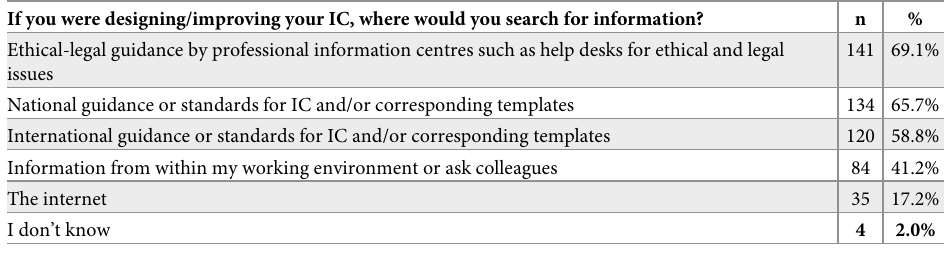
Table 10. Preferences of information sources for designing and improving IC.